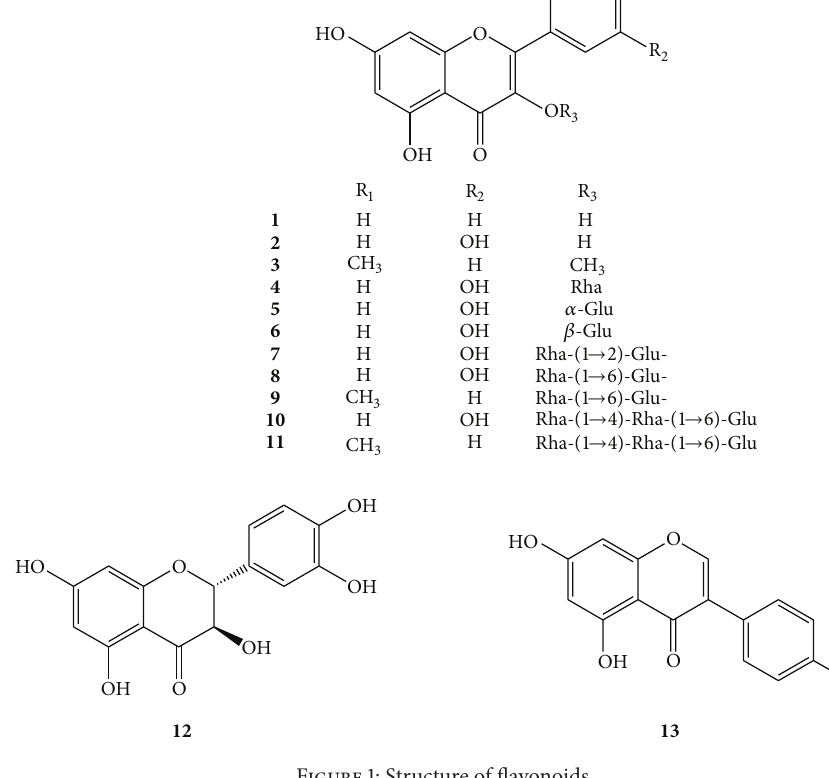
Figure 1: Structure of flavonoids.